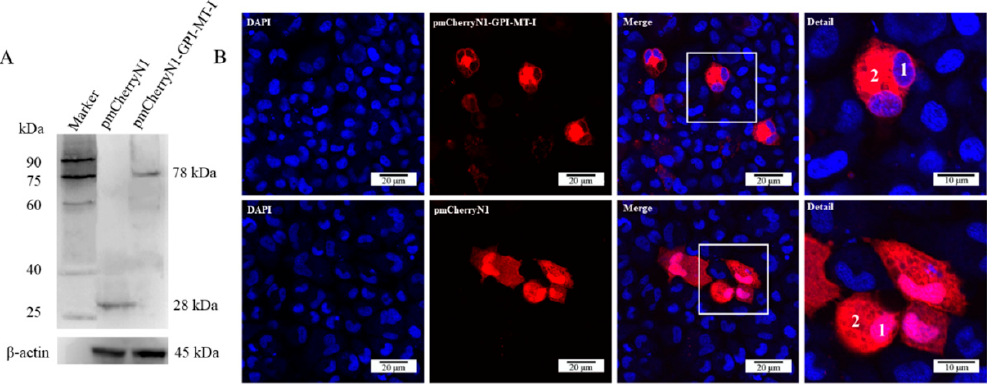
Figure 6. ( A ) Western blot was used to verify the overexpression of the AdGPI-MT-I protein in GSM cells. GSM cells were transfected with pmCherryN1 vector or pmCherryN1-AdGPI-MT-I plasmid DNA for 48 h and then harvested for western blot. β -actin was used as an internal reference. ( B ) Confocal microscopy was used to observe the subcellular localization of the AdGPI-MT-I protein in GSM cells (scale bar, 20 μ m). Nuclei were stained with DAPI. The nucleus and cytoplasm are marked with the numbers 1 and 2, respectively.